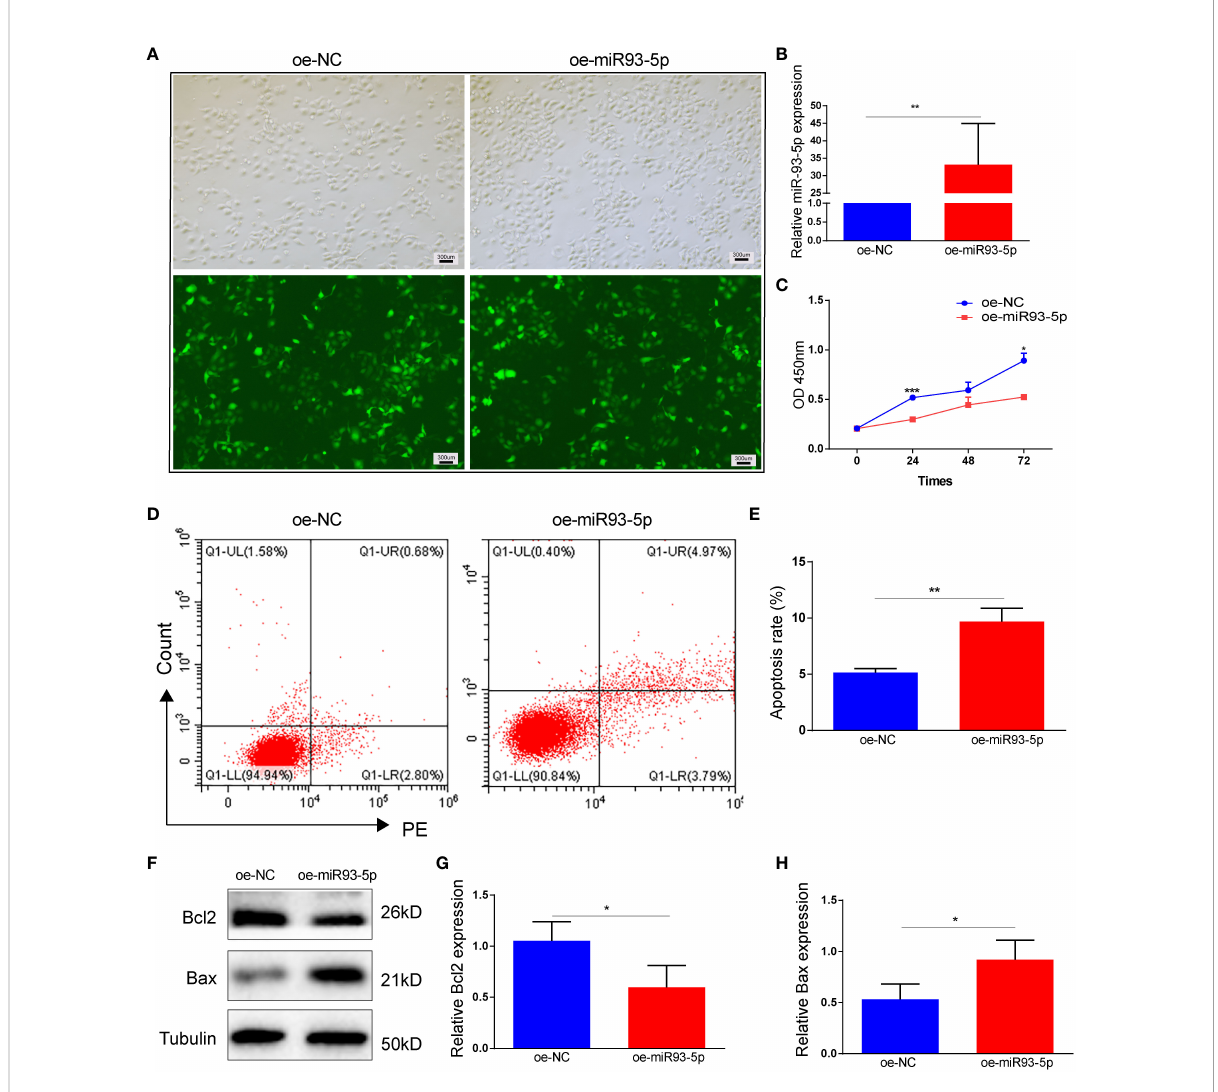
FIGURE 2 The effect of overexpression of miR-93-5p on the apoptosis in GC. (A) Cells were transfected with the oe-NC and oe-miR93-5p lentivirus for 72h. (B) The expression of miR-93-5p in GCs detected by RT-qPCR. (C) Cell viability in the oe-NC and oe-miR93-5p groups detected by CCK-8 assay. (D, E) Flow cytometry assay displayed the apoptosis level in two groups and bar charts are used for visualization. (F – G) Bax and Bcl-2 protein expression were determined by western blotting in two groups. p < 0.05 ( “ * ” ), p < 0.01 ( “ ** ” ), p < 0.001 ( “ *** ”